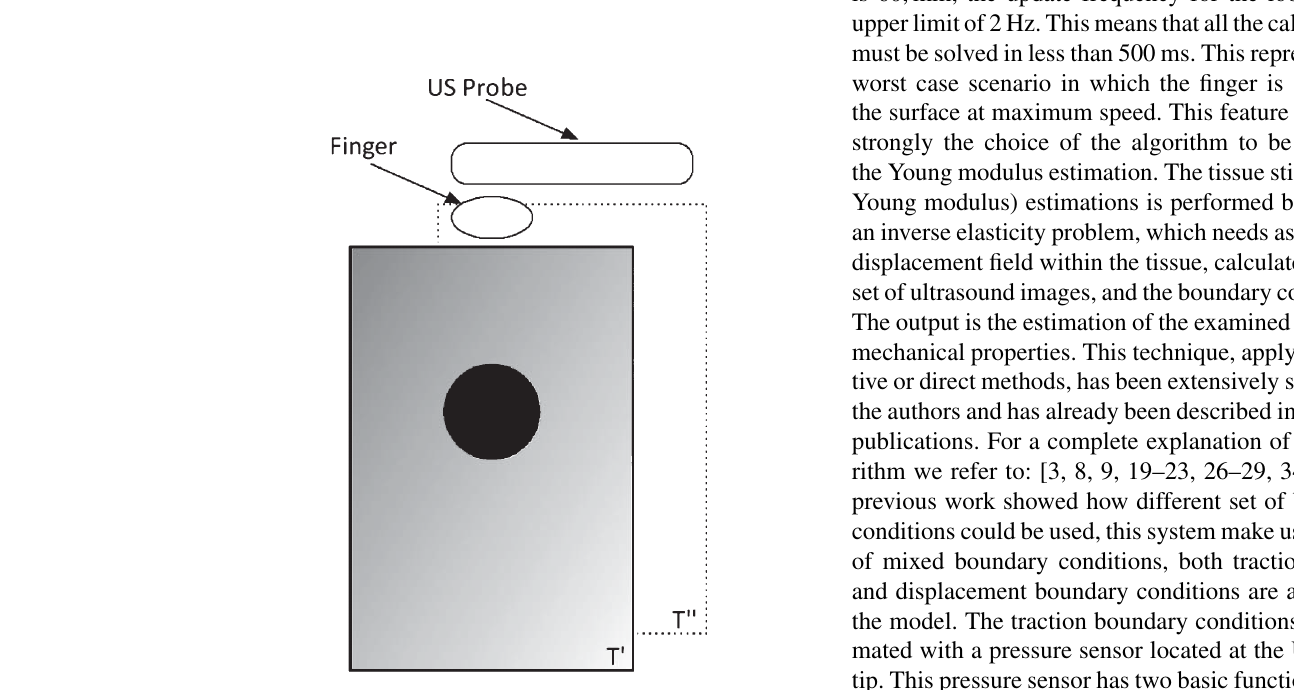
Fig. 4. Two different strategies for the exploration of the surface by the ultrasound probe have been presented. The second strategy pro- poses that: The different sections of a certain volume are calculated sequentially. The volume will become available slice by slice in the virtual